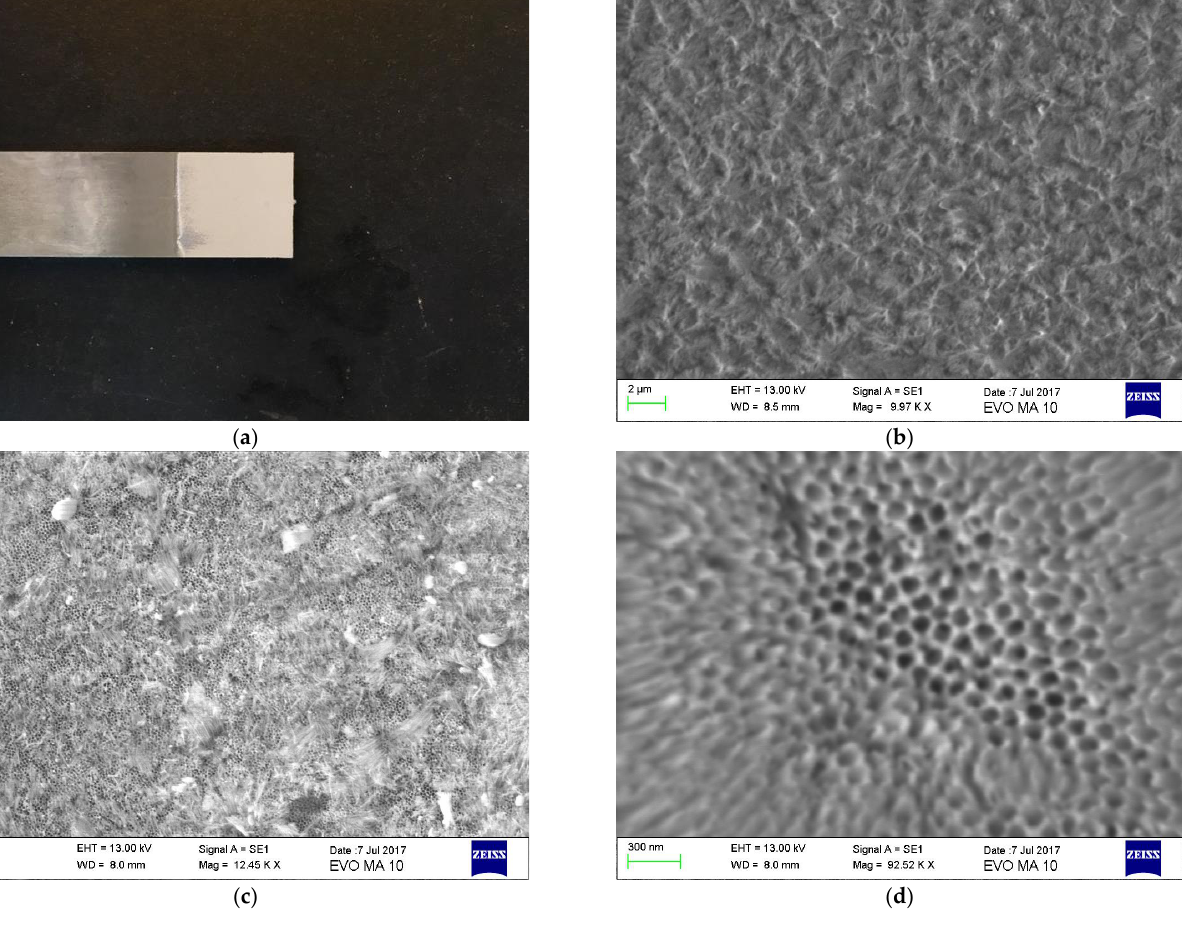
Figure 6. Micrographs of aluminum plate: ( a ) adherend after anodic treatment, ( b ) SEM after the second anodization step, ( c ) SEM after the third anodization step, without ultrasonication and ( d ) SEM after ultrasonication.